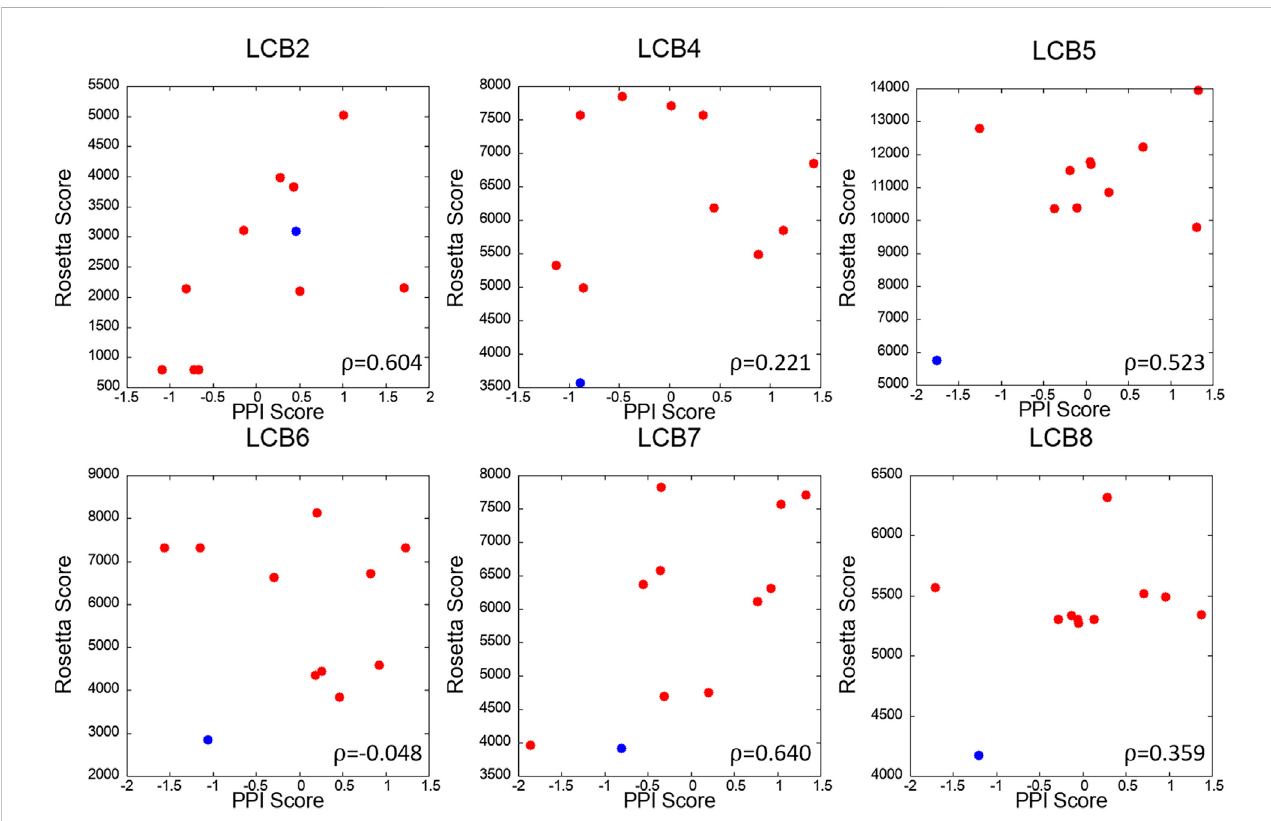
FIGURE 9 Correlation of PPI Score and the Rosetta binding energy for each LCB and its decoys. The x -axis is the average Z-scores of PPI Scores (computed from LCB1 and LCB3), and the y -axis is Rosetta score of the complex. The red dots are 10 mutants generated by Rosetta and the blue dot is the starting binder. Pearson ’ s correlation coef fi cient of each scatter plot is written the lower right corner of the